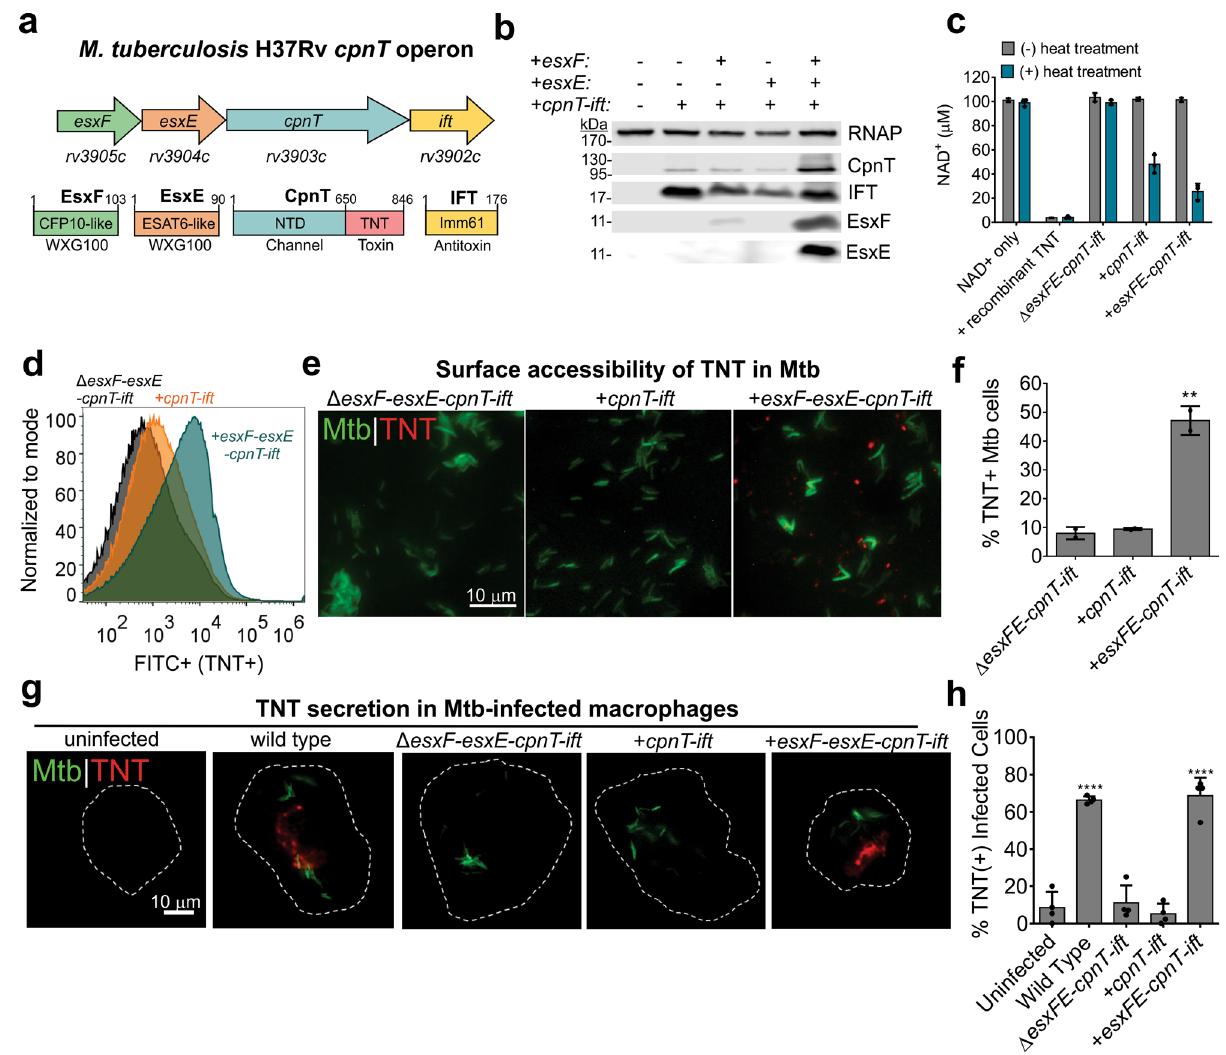
Fig. 1 EsxE-EsxF are required for TNT surface accessibility and secretion by M. tuberculosis . a The cpnT operon of Mtb and the domain organization of the encoded proteins. TNT tuberculosis necrotizing toxin, IFT immunity factor to TNT, NTD N-terminal domain. b CpnT protein levels are dependent on EsxE and EsxF. Immunoblot of Mtb whole-cell lysates detected by antibodies speci fi c for the indicated proteins. CpnT was detected using an anti-TNT antibody for the C-terminal domain. RNA polymerase (RNAP) was used as a loading control. Representative of two experiments. c The NAD + glycohydrolase activity of Mtb is dependent on EsxE and EsxF. The NAD + glycohydrolase activity of whole-cell lysates of Mtb strains was determined without or with heat treatment at 65 °C to release the antitoxin from TNT. The residual NAD + concentration was measured by conversion of NAD + to a fl uorescent intermediate after NaOH treatment. NAD + with only buffer and with added recombinant TNT were used as negative and positive controls, respectively. Representative experiment shown from two separate trials. d , e Surface accessibility of TNT of the indicated Mtb strains by fl ow cytometry using an α -TNT antibody and FITC-conjugated secondary antibody ( d ) and by fl uorescence microscopy of Mtb strains stained with DMN-trehalose (green), and probed with α -TNT and Alexa fl uor-594-conjugated secondary antibody ( e ). f Quanti fi cation of e . Percentage of TNT-positive cells out of total bacteria from at least fi ve fi elds of view. N ≥ 1000 bacterial cells total over two independent experiments. Shown is mean and standard deviation from two experiments. The statistical analysis was performed using one-way ANOVA analysis with Dunnet ’ s multiple comparison test using the Δ esxFE-cpnT-ift strain as the negative control. P = 0.0018. g Detection of TNT in the cytosol of Mtb-infected macrophages is dependent on EsxE and EsxF. Shown are THP- 1 macrophages 48 h after infection with Mtb. THP-1 cells were treated with digitonin to only permeabilize the plasma membrane and were probed with anti-TNT antibody (Alexa fl uor-594, red). h Quanti fi cation of g . Infected macrophages were scored as TNT + or TNT − based on the presence or absence of bright red punctae and quanti fi ed as % TNT-positive cells. At least 100 cells were analyzed of at least four independent experiments. Data shown is the mean ± SD for four biological replicates. Statistical analysis was performed using one-way ANOVA with Dunnet ’ s multiple comparison test compared to the uninfected sample as the negative control. P < 0.0001. Source data are provided in the Source data fi